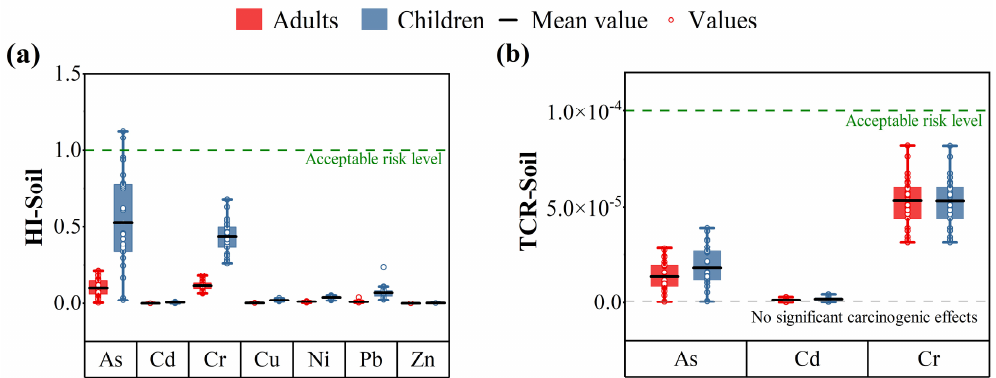
Figure 5. Non ‐ carcinogenic and carcinogenic risks of heavy metals for children and